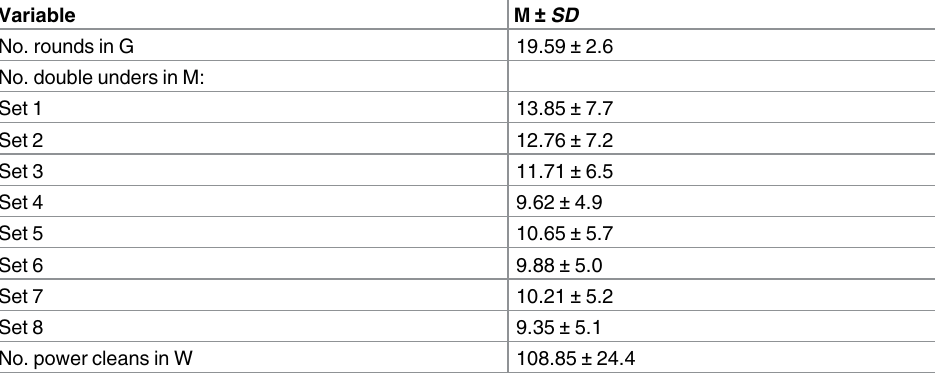
Table 2. Performance data recorded in the three CrossFit WOD.